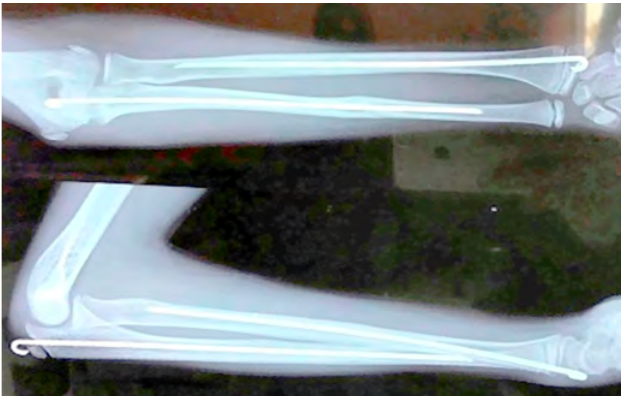
Fig 9: X-ray of forearm showing union of fractured radius and ulna